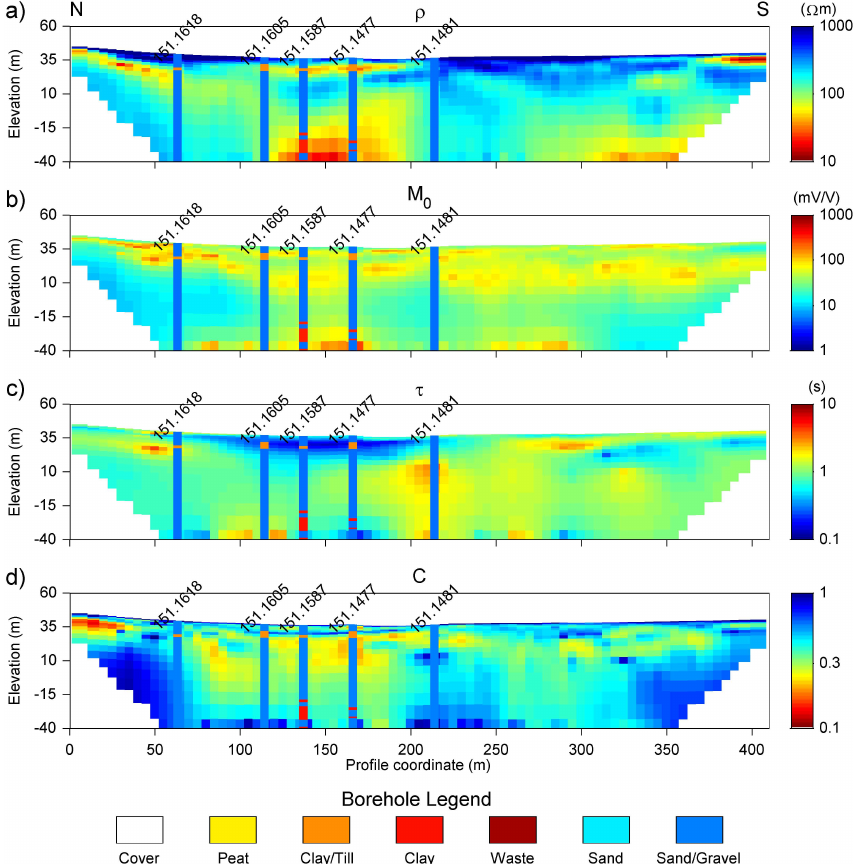
Fig. 9. Inverted sections for profile 4 (see location on the map Fig. 1) with superimposed boreholes. (a) Resistivity section, (b) Chargeability M 0 , (c) τ parameter, (d) c